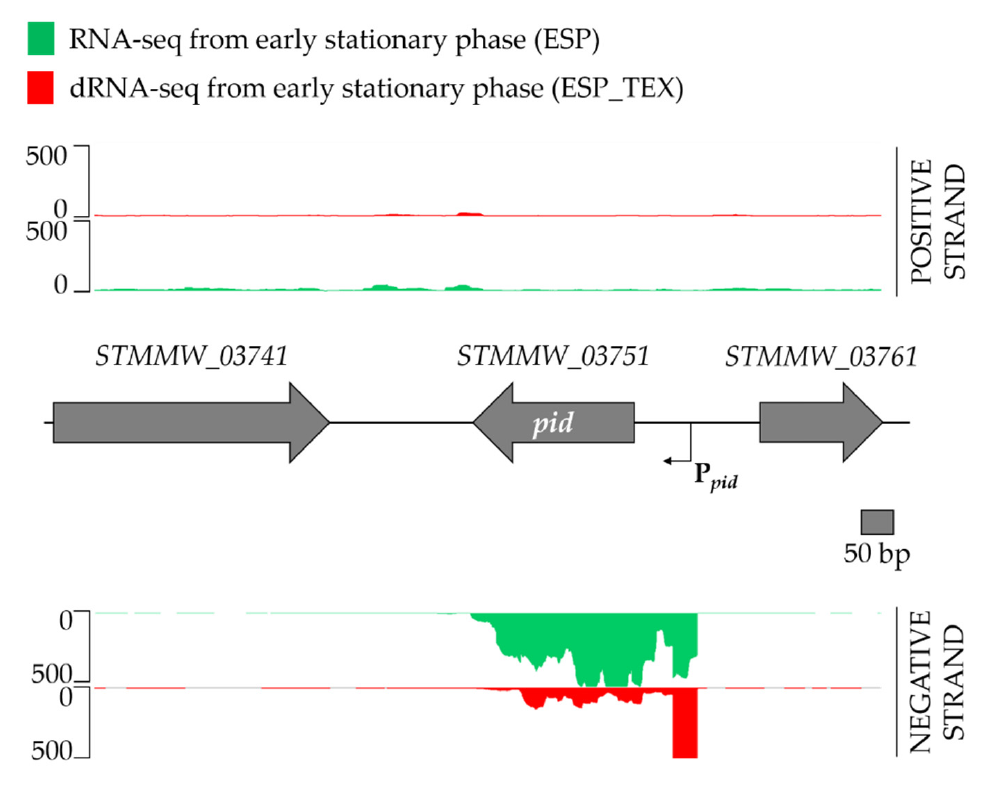
Figure 4. Identification of the transcription start site of the pid locus in prophage BTP1. RNA- sequencing reads mapped to the positive and negative strand are shown in the upper and lower panels, respectively. The scale is 0–500 normalized reads. Normalized RNA-seq data from early stationary phase are shown in green, and differential (d)RNA-seq data from early stationary phase are shown in red. dRNA-seq data are derived from RNA treated with terminator exonuclease (TEX) to enrich for transcripts carrying a 5 (cid:48) triphosphate (primary transcripts), enabling more precise identification of transcription start sites. The TSS of pid (indicated with an arrow) was located 174 bp upstream of the start codon of the pid coding sequence, at nucleotide position 389,658 on the D23580 chromosome. RNA-seq and dRNA-seq data were reinterpreted from Hammarlöf et al. (2018)